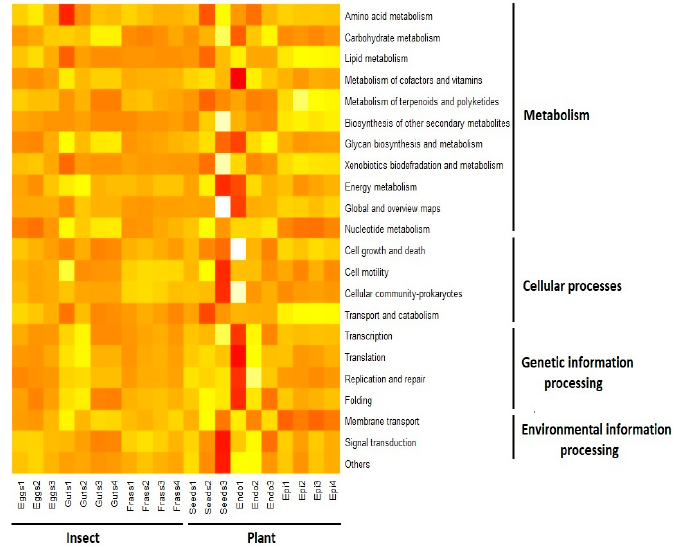
Figure 4. Heatmap of the functional categories inferred from samples collected from the plant D. inoxia and its specialist insect L. daturaphila . Each column corresponds to a sample, and rows correspond to a specific functional category. The lightest colours represent the highest values, while darker colours correspond to the lowest values.